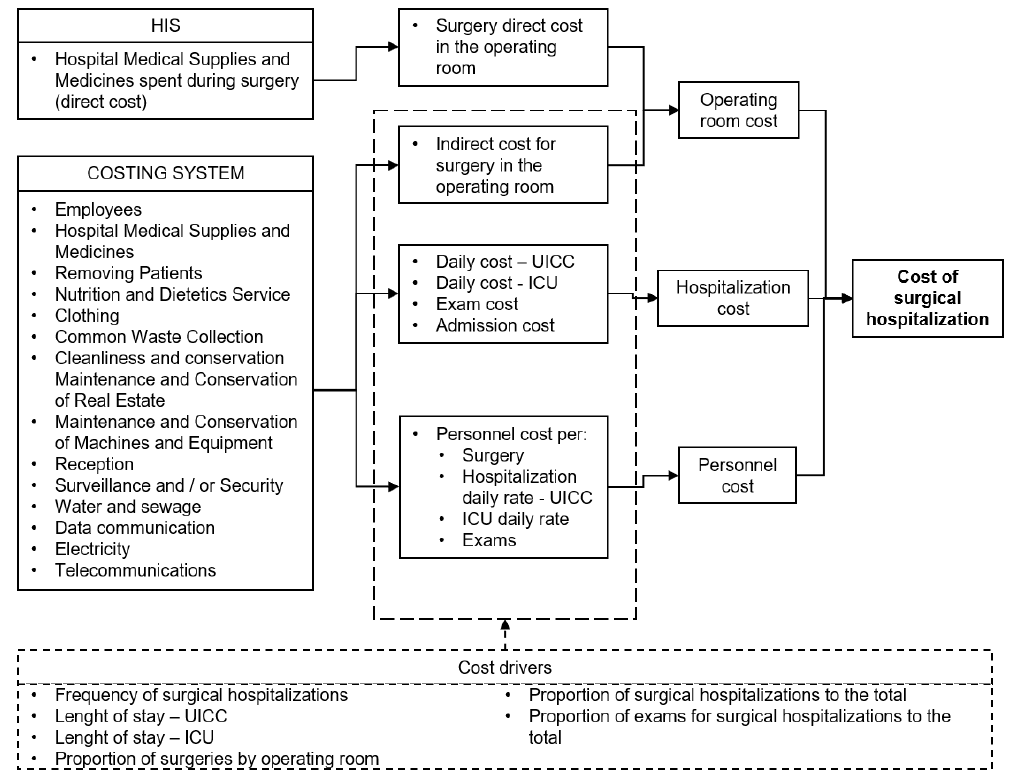
Figure 3. Surgical hospitalization cost model.